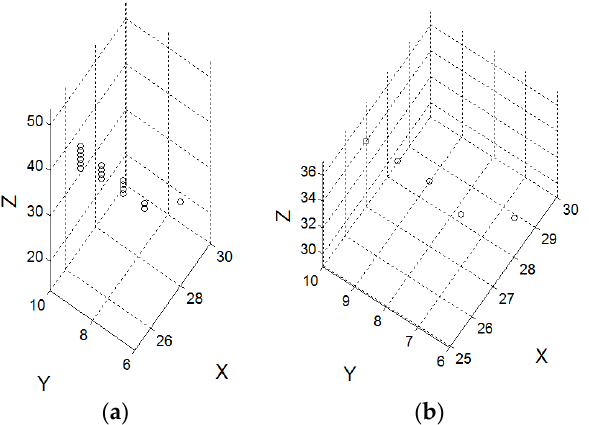
Figure 6. Example of thinning the voxels of a pyramid structure by the partial parallel thinning algorithm. ( a ) A result after 10 iterations of thinning procedures; ( b ) A result after 20 iterations of thinning procedures.